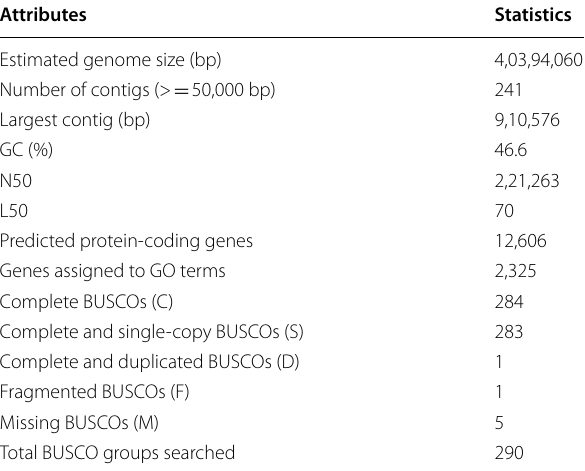
Table 3 Genome sequencing and assembly statistics of